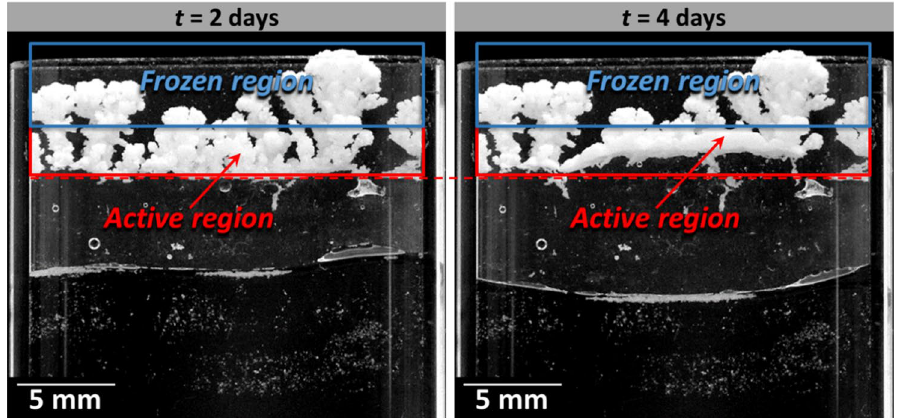
Figure 7. Salt crust active and frozen regions. Changes in the crust morphology only occur in the active region between the two times indicated in the pictures (stage